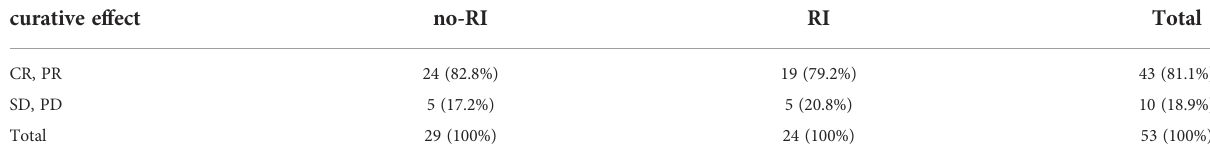
TABLE 4 Effects of chemotherapy in different groups on renal function